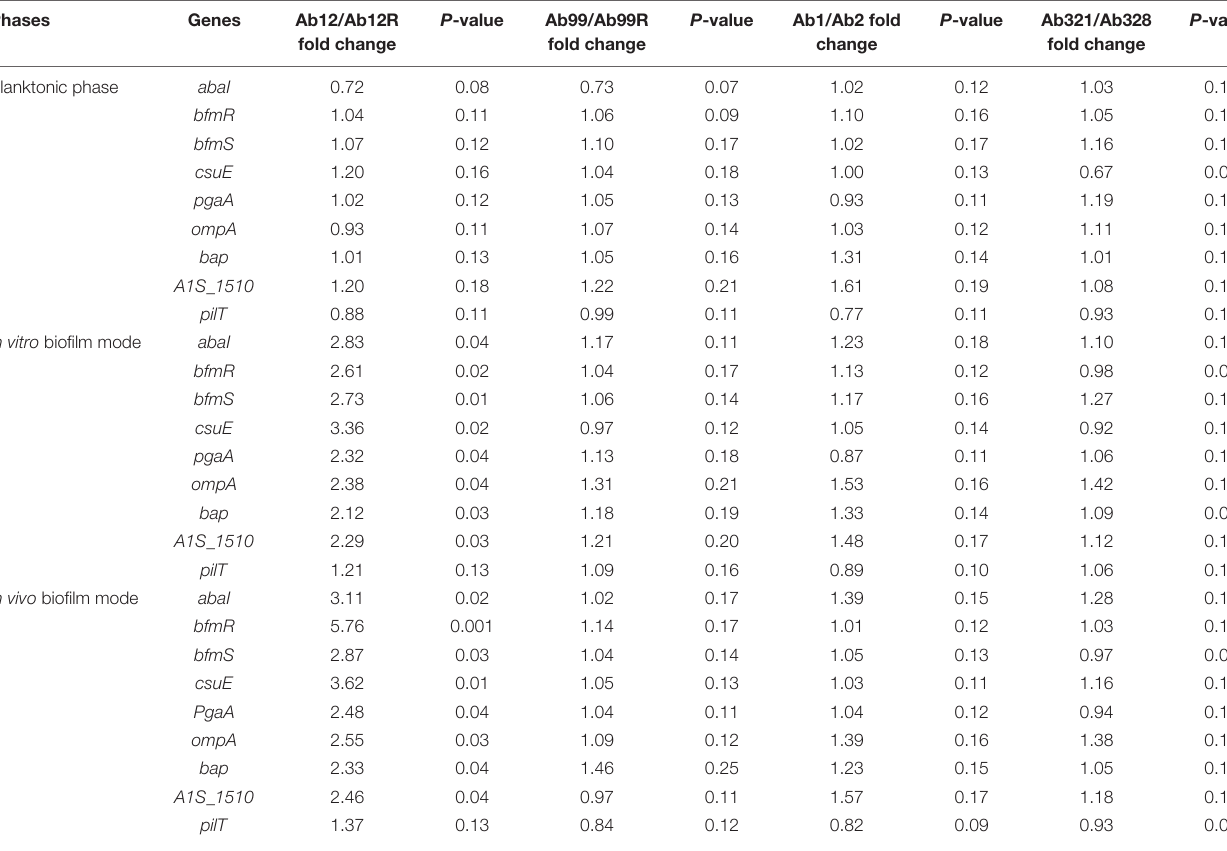
TABLE 2 | Expression levels of genes in planktonic cells, in vitro and in vivo biofilm modes between colistin-susceptible when compared with colistin resistance strains as measured by qRT-PCR. Phases Genes Ab12/Ab12R fold change Planktonic